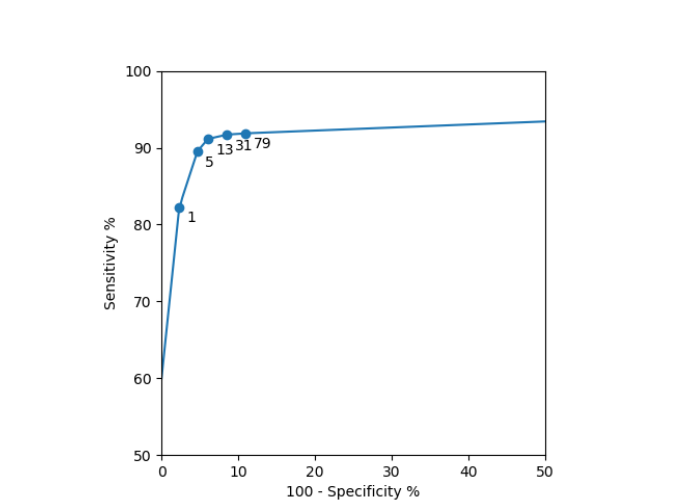
Figure 11. ROC curve (top-left quadrant) of our Mini U-Net for garbage detection. Each bullet represents a different network trained with that specific w dirt parameter. Other hyperparameters: lr = 0.0001, epochs = 1000, bottleneck layer number of features = 256. Table 2. IOU and DICE metrics computed training the network with different w dirt weights.